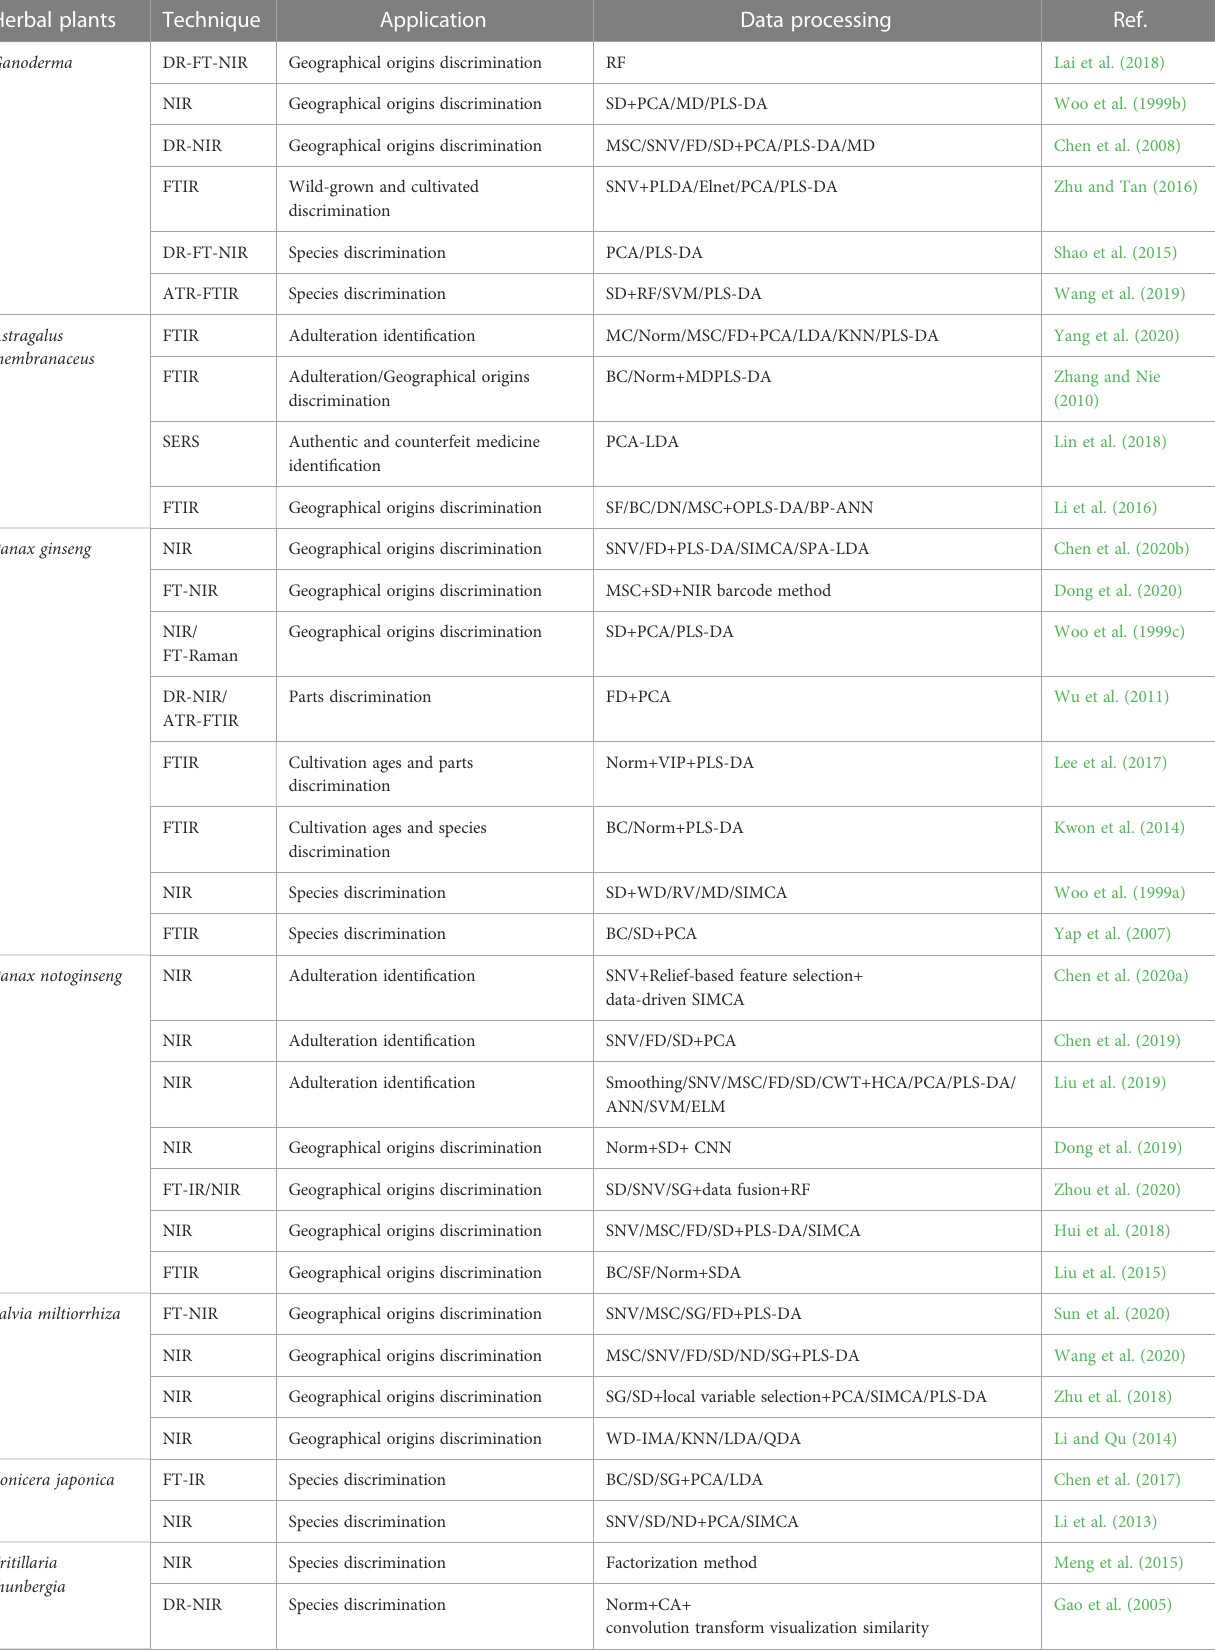
TABLE 3 Summary of qualitative analyses of herbal raw materials based on IR and Raman spectroscopy. Herbal